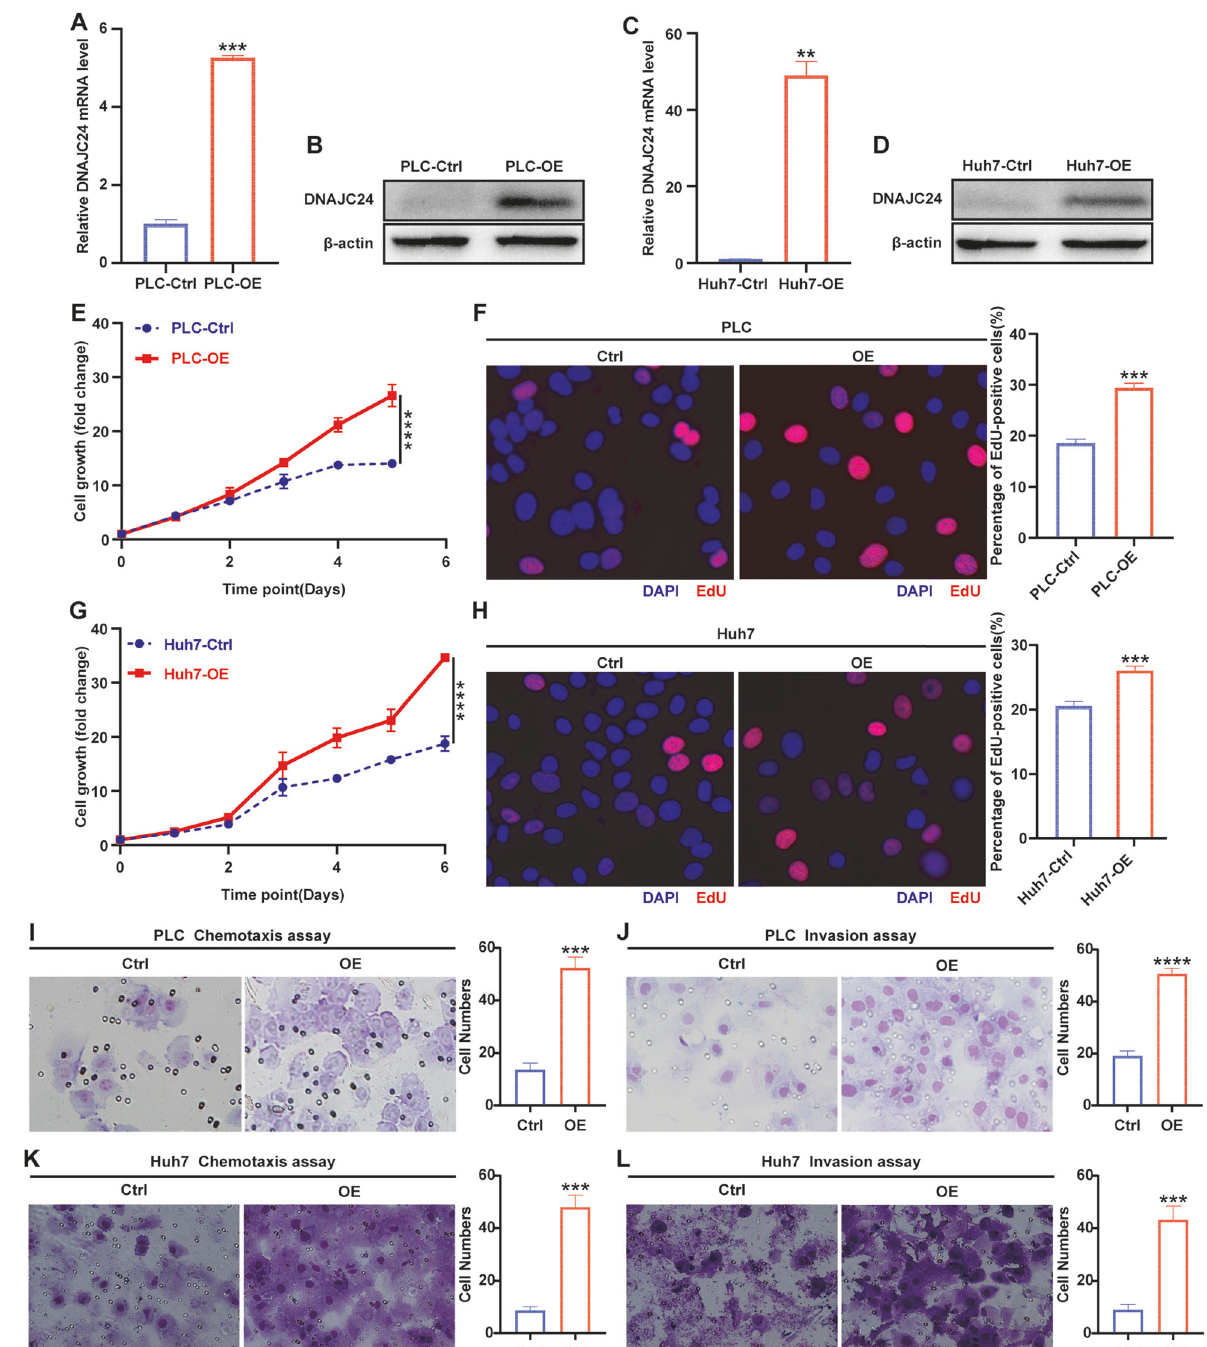
Fig. 2 DNAJC24 promotes proliferation and motility of HCC cells in vitro. A , C PLC and Huh7 cells were infected with a lentivirus to produce stable DNAJC24 overexpression (OE) cells. qRT-PCR was performed to determine levels of DNAJC24 mRNA. β -actin was used as an internal control. B , D Western blotting was performed to determine levels of DNAJC24 protein. E , G CCK-8 cell viability assay analysis of the impact of DNAJC24 ectopic overexpression on PLC ( E ) and Huh7 ( G ) cell growth. Results were normalized to viability at day 0 and represented as fold change. F , H The effect of ectopic overexpression of DNAJC24 on the proliferation of PLC ( F ) and Huh7 ( H ) cells was analyzed by EdU staining. Representative images and EdU positive cell rates are as shown. I – L Chemotaxis ( I , K ) and Matrigel invasion ( J , L ) assays were used to detect the effect of ectopic overexpression of DNAJC24 on PLC ( I , J ) and Huh7 ( K , L ) motility. Data were presented as mean ± SEM. n = 2 – 5. ** P < 0.01, *** P < 0.001, **** P < 0.0001. (Baf-A1), which allows one to infer the rate of LC3-II neosynthesis observed phenomenon may be caused by blocked fusion of [34, 35]. Interestingly, in the presence of Baf-A1, knocking down autophagosome and lysosome or disrupted lysosome function, as DNAJC24 didn ’ t result in the accumulation of LC3B-II (Fig. 5A right previously reported [35, 36]. Next, we performed the experiments in and B right), nor did p62 (Fig. 5C right and D right) change the presence of the lysosomal pump inhibitor Ba fi lomycin A1